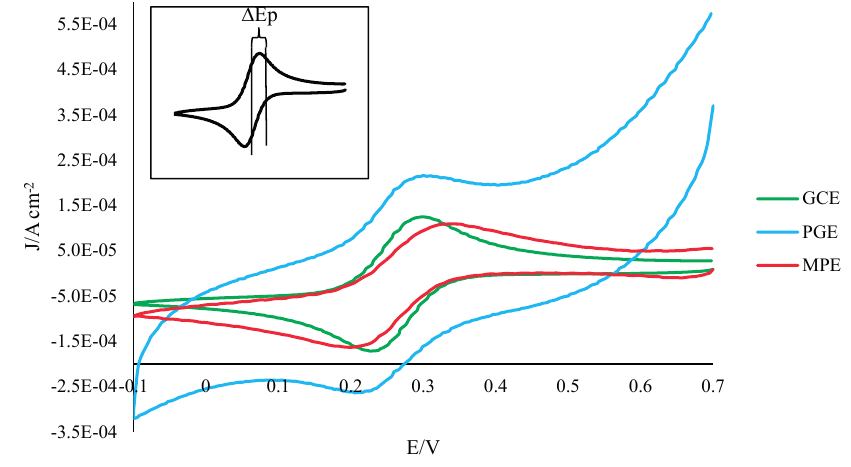
Figure 1. Representative voltammograms of GCE, MPE and PGE electrodes in 1 mM ferricyanide solution. To account for differences in exposed area, current is given as a function of raw current divided by electrode surface area. Initial potential = 0.7 V; vertex potential = − 0.1 V; final potential = 0.7 V; scan rate = 0.05 V/s. Table 1. Characterization of electrodes in 1 mM ferricyanide. Initial potential = 0.7 V;